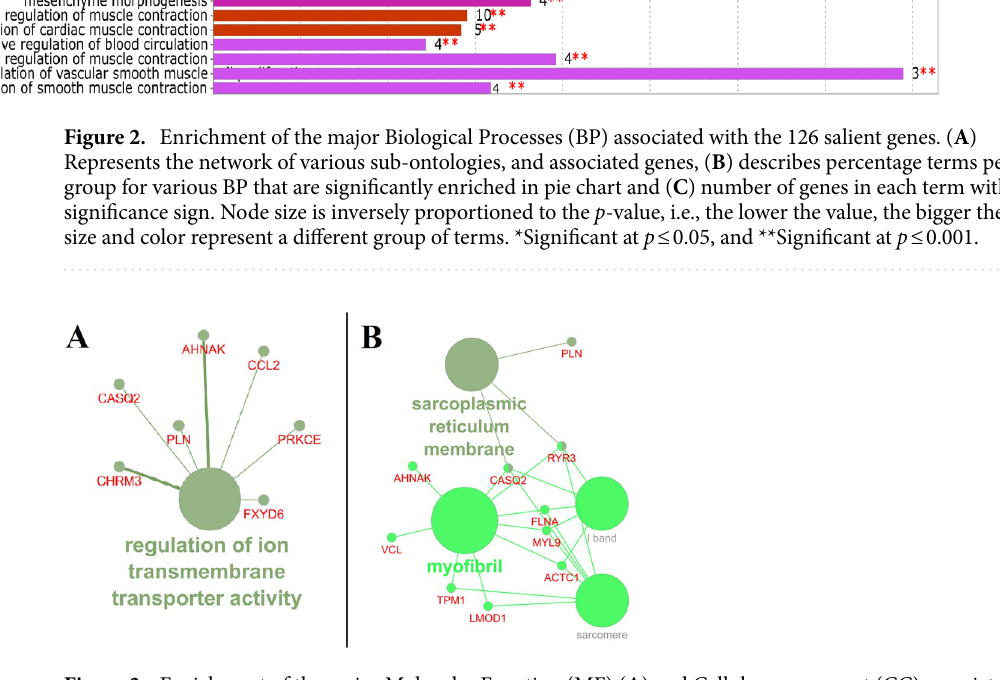
Figure 3. Enrichment of the major Molecular Function (MF) ( A ) and Cellular component (CC) associated with the 126 salient genes. ( A ) Describes percentage terms per group for various MF that are significantly enriched, and ( B ) shows various sub-ontologies of CC and associated genes. Node size is inversely proportional to the p-value, i.e., the smaller the value more considerable the node size and colour represents a different group of